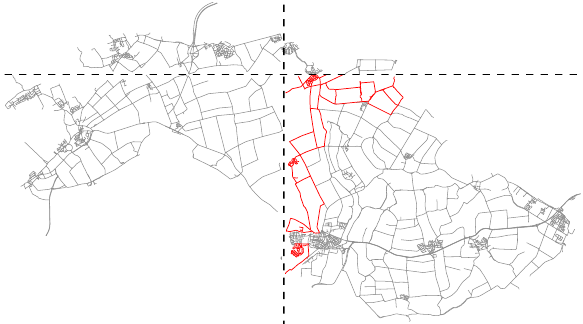
Figure 4: The inward ‘read-only’ buffer example for a subset of the road network dataset with only four field at the bottom. The buffer for right bottom field in the figure is illustrated in